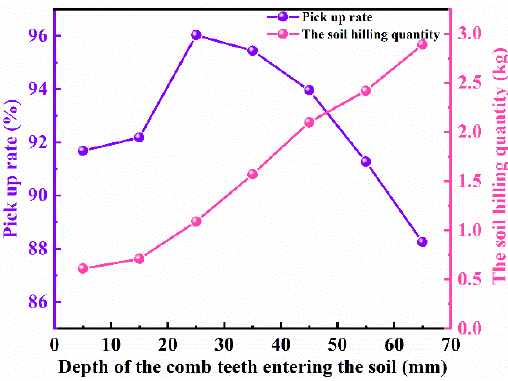
Figure 13. Influence of different DCS on test index.